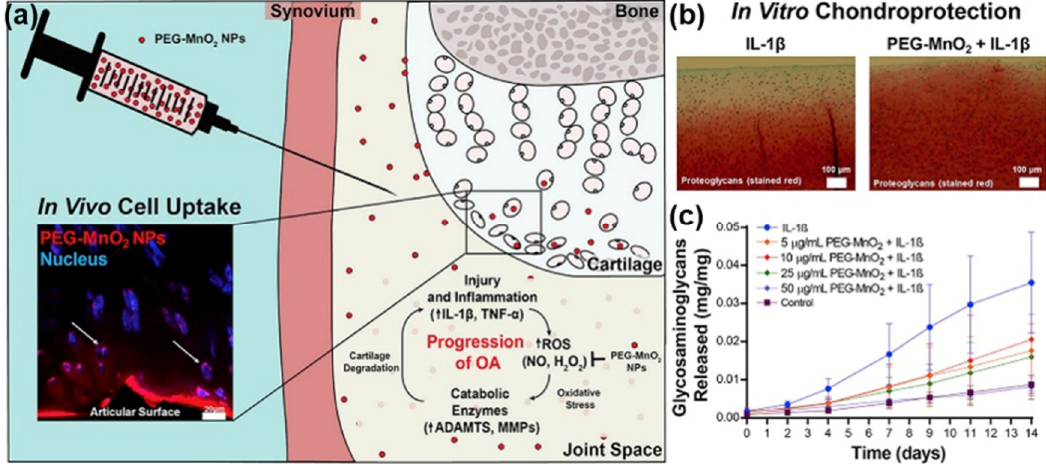
Figure 4. Anti-OA effects of MnO2 NPs. ( a ) The chondroprotective mechanism of MnO2 NPs and their intracellular localization in IL-1β-induced OA model. ( b , c ) MnO2 NPs preserved the ECM of cytokine-challenged explants. Reproduced from [157], with permission from Copyright Elsevier, 2019.